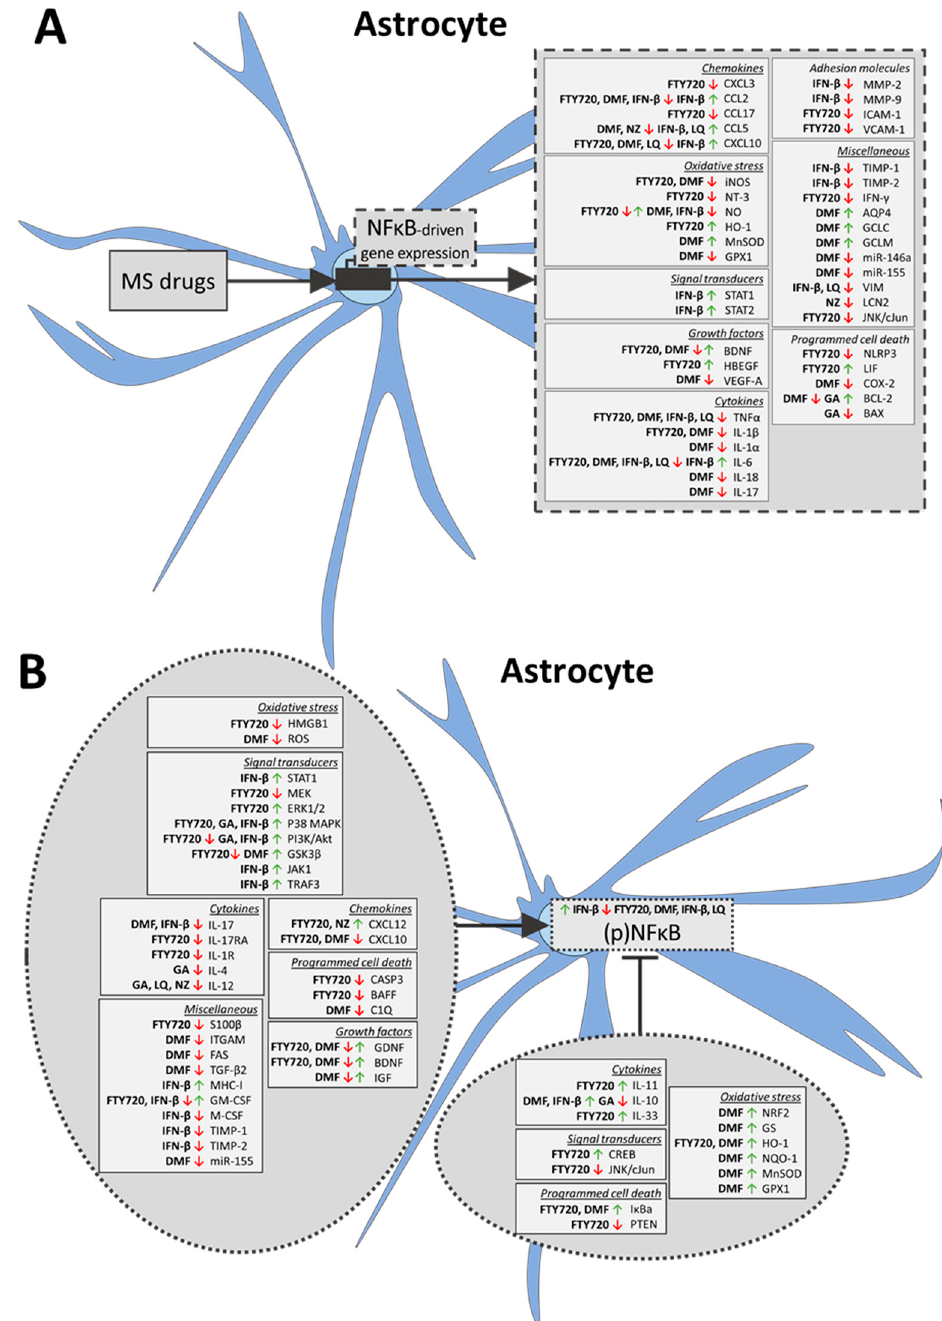
Figure 3. MS drugs directly or indirectly target NF κ B signaling in astrocytes. The effects of MS drugs on ( A ) NF κ B-driven gene expression and ( B ) the expression of genes known to affect NF κ B signaling are shown. Black arrows: stimulation; bar-headed line: inhibition; red arrows: decreased expression; green arrows: increased expression. Genes mentioned within the rectangular frame are under transcriptional regulation of NF κ B. Genes mentioned within the circular frames are upstream regulators of NF κ B.